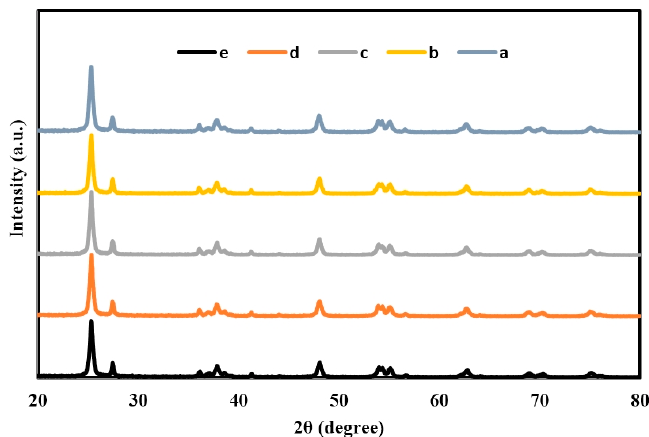
Figure 1. X ‐ ray diffraction pattern: (a) TiO 2 , (b) 0.6 wt % Er 3+ /TiO 2 , (c) 1.2 wt % Er 3+ /TiO 2 , (d) 1.8 wt % Er 3+ /TiO 2 , and (e) 2.4 wt % Er 3+ /TiO 2 .